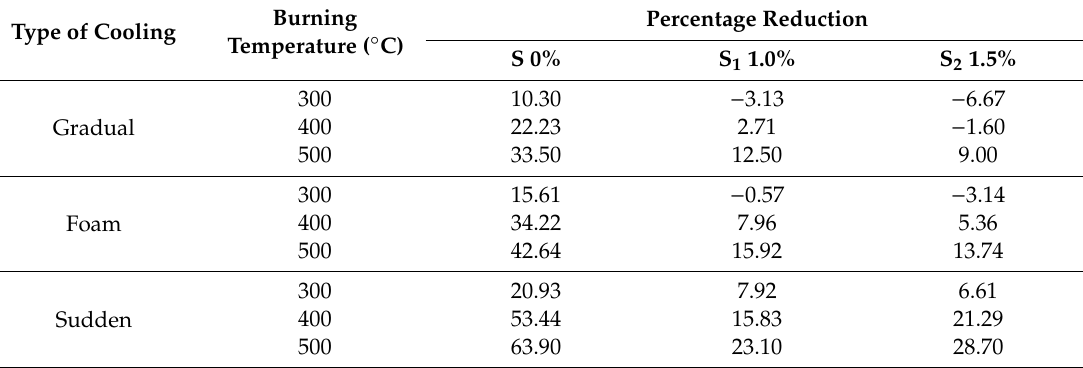
Table 7. Compressive strength percentage reduction concerning all types of cooling for the adopted (RPC)